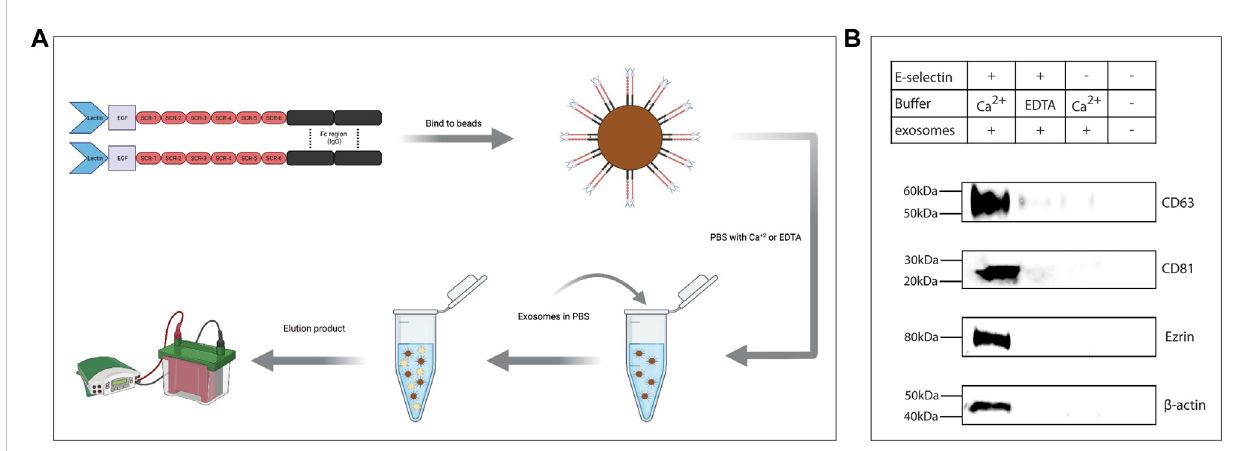
FIGURE 3 E-selectin is able to pull down intact exosomes expressing E-selectin ligands. (A) Cartoon illustrating the experimental work fl ow. rE-selectin-IgG wasboundtomagneticbeadscoatedwithproteinG.ThecomplexwasresuspendedinPBScontainingeither2 mMofCa 2+ or20 mMofEDTA.Exosomes were added to that mixture, and after overnight incubation, the particles bound to the E-selectin-beads complex were eluted and lysates were analyzed by western blot. Refer to Materials and Methods for more details. Figure created with BioRender.com. (B) Western blot analysis of the eluted products from the E-selectin-bead complex. Control samples either containing EDTA to chelate out Ca +2 or beads (without the E-selectin) were used to verify the speci fi city of the interactions. A bead alone control (without exosomes) was also included. Blots were stained for the common markers of exosomes: CD63 and CD81, but also from proteins revealed from the Mass Spectrometry data such as ezrin and β -actin. This is representative of n = 3 independent